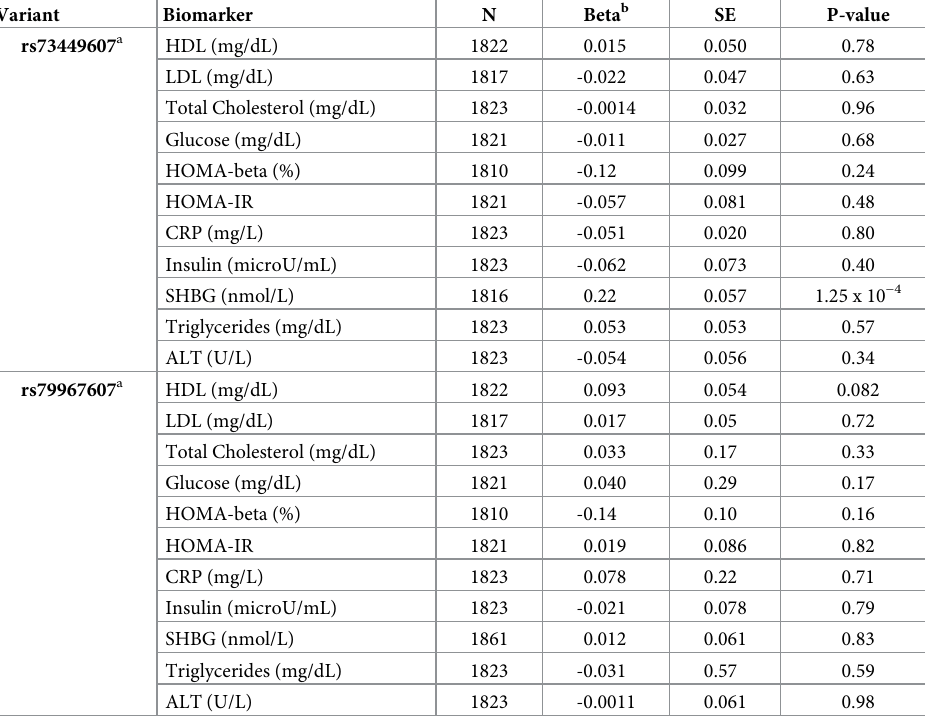
Table 5. The association between rs3449607 or rs79967607 and obesity-related biomarkers in the